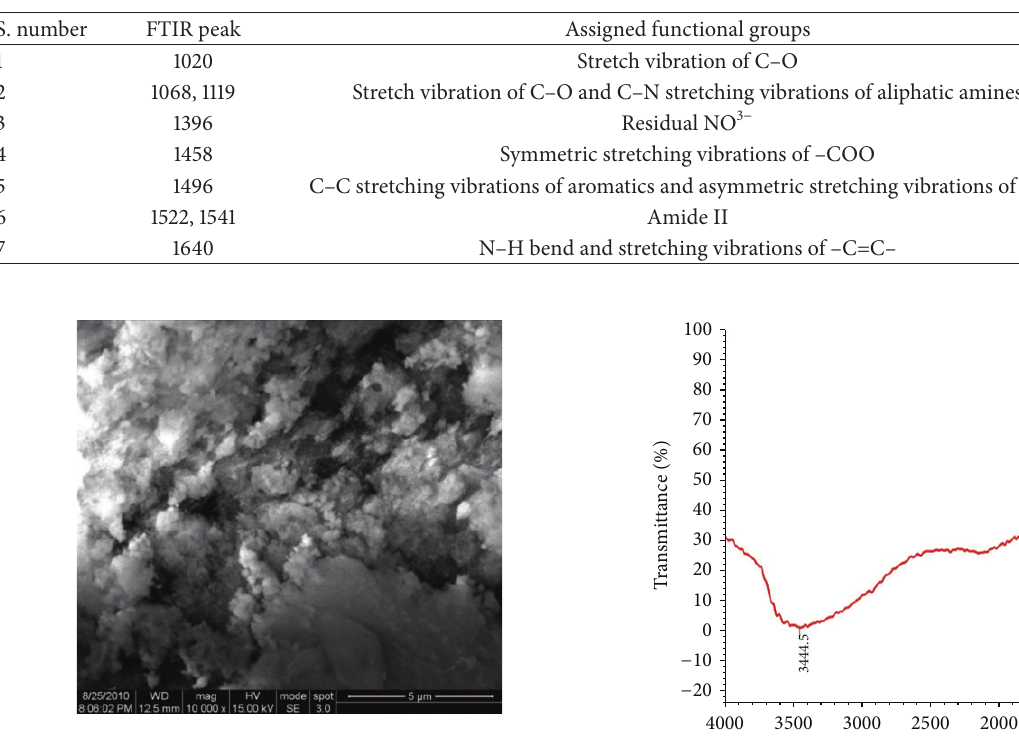
Figure 3: Scanning electron micrograph of silver nanoparticles. WD: working distance between the sample surface and the low portion of the lens which should be greater than 4 mm (12.5mm); Mag: magnification at 10000x; HV: high voltage (15kV); Mode: secondary electron (SE) mode.